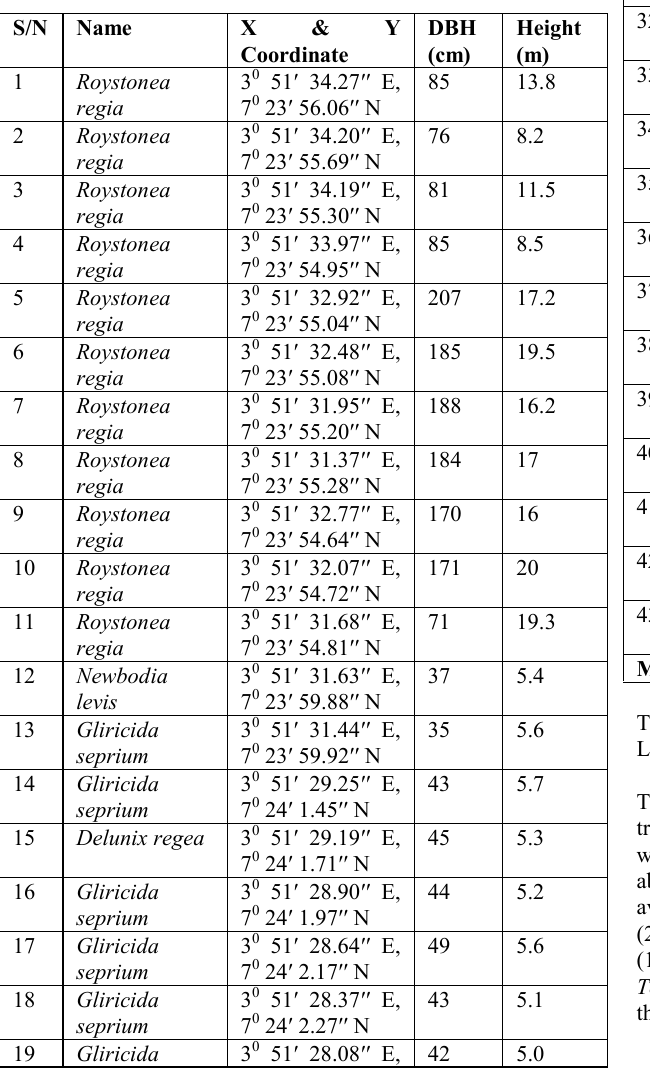
Figure 4. Spatial Distribution of Avenue Trees